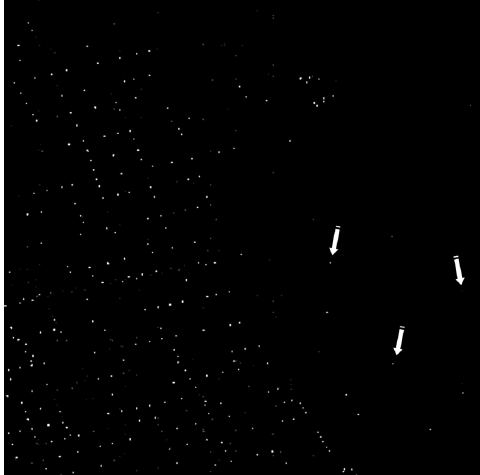
Fig. 2. VIRS 200 grey scale image of Viareggio displayed in the 9th channel (546.25 nm). White ar- rows indicate the position of faint city